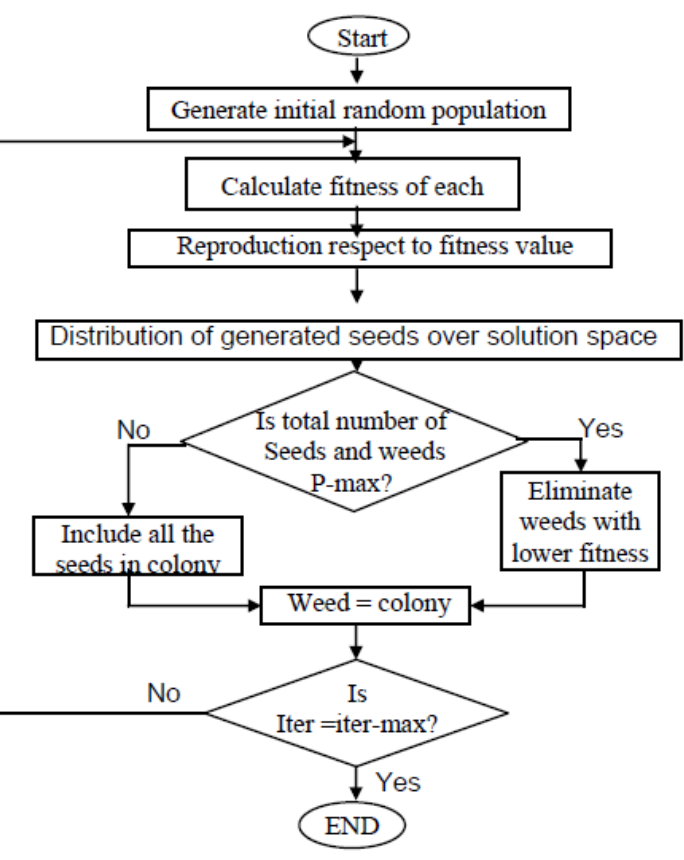
Figure 7. Structure of the weed algorithm (WA).